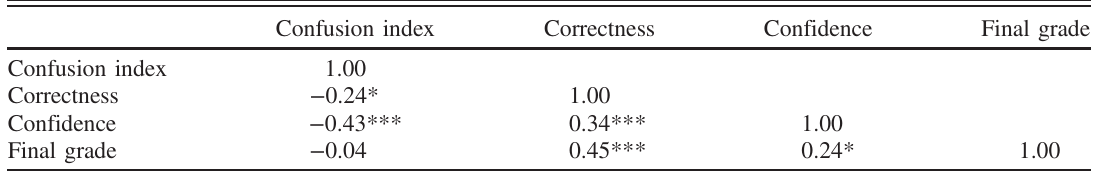
TABLE I. Correlations of characteristics of student learning and engagement, fall 2010 ( N ¼ 106 ).